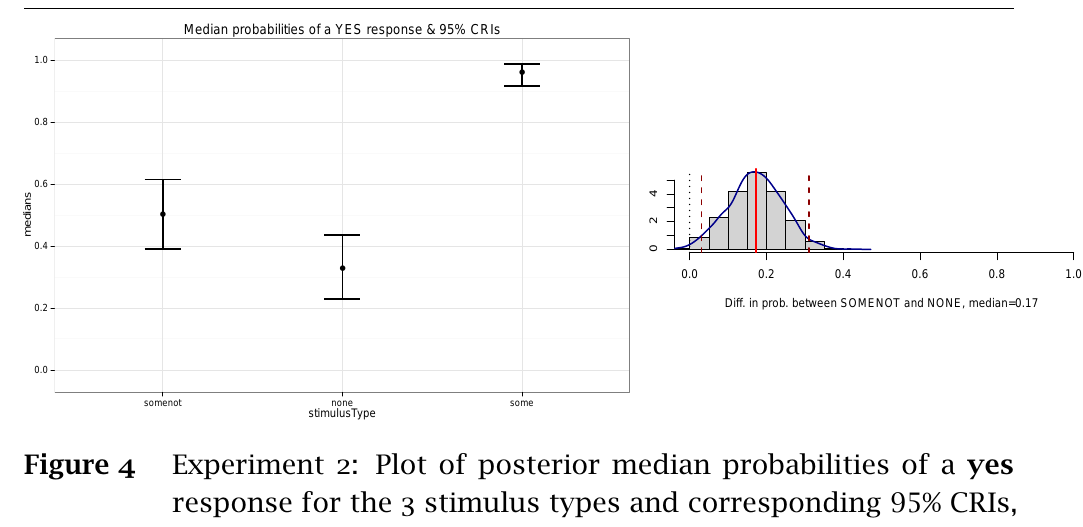
Experiment 2 : Plot of posterior median probabilities of a yes response for the 3 stimulus types and corresponding 95 % CRIs, and histogram of the posterior difference in probability of a yes response between somenot and none